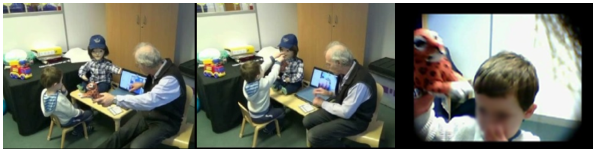
Figure 2: The child is learning that the screen shows what the robot is seeing. The child will move the object into and out of the robot’s view, and the robot will give positive feedback when it can ‘see’ the object – not too close to, and not too far away from its face.